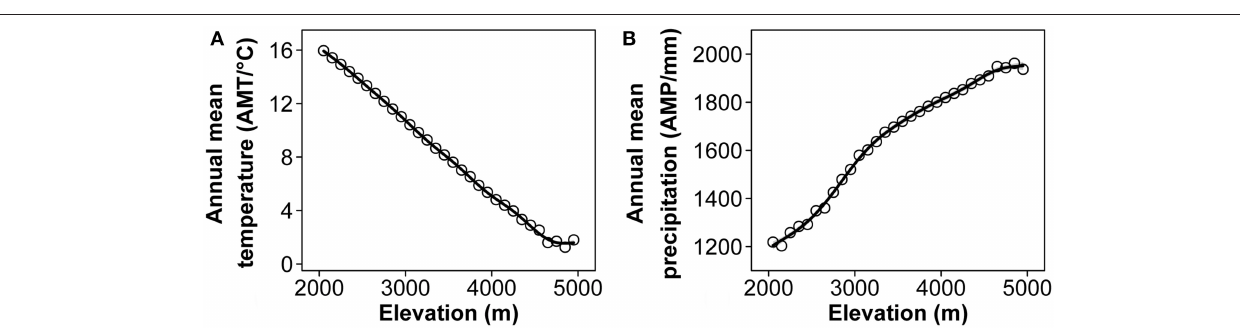
FIGURE 2 | The annual mean temperature (AMT) (A) , and the annual mean precipitation (AMP) (B) change along the elevational gradient of Mount Kenya. All data were downloaded from the Worldclim database